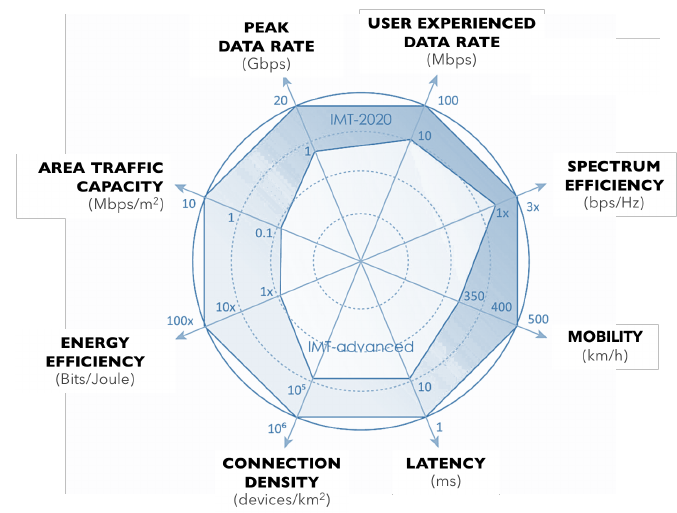
Figure 6. Some major goals articulated for 5G. Adapted from resources made available by the European Telecommunications Standards Institute